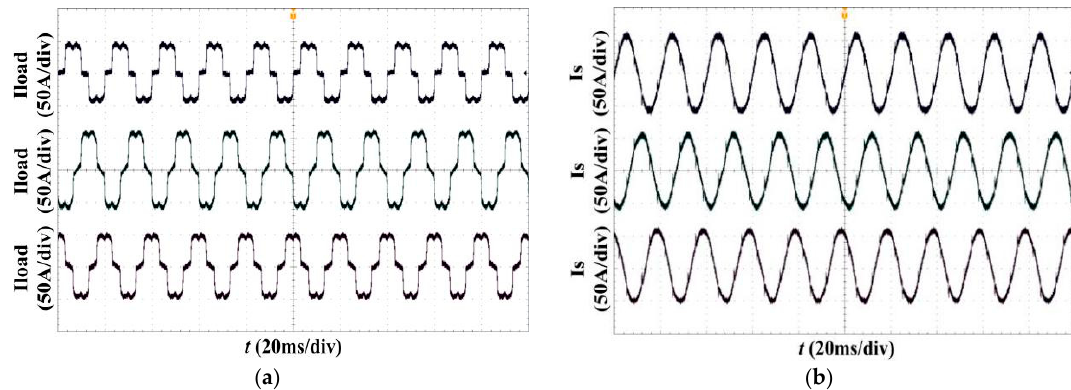
Figure 9. Three-phase load and grid currents with the unbalance load when U sn = 220 V and U dc-ref = 640 V. ( a ) Before compensation; and ( b ) after compensation.